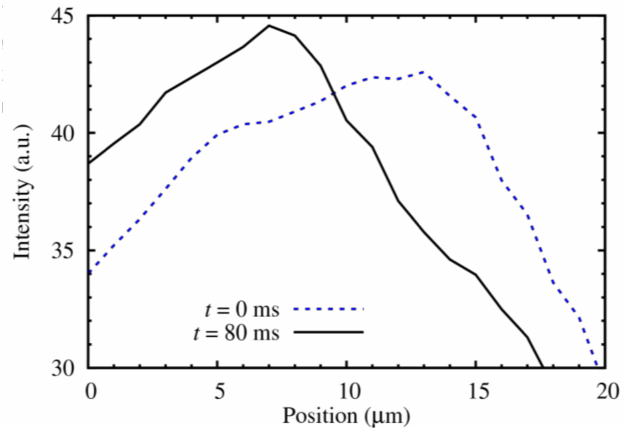
Figure 4. Light intensity versus pixel position at t = 0 ms, when negative DEP is applied, and at t = 80 ms for the 37 U/mL in 10 µ L. The electrode is located on the right side of the PM layer, as shown in Figure 3.